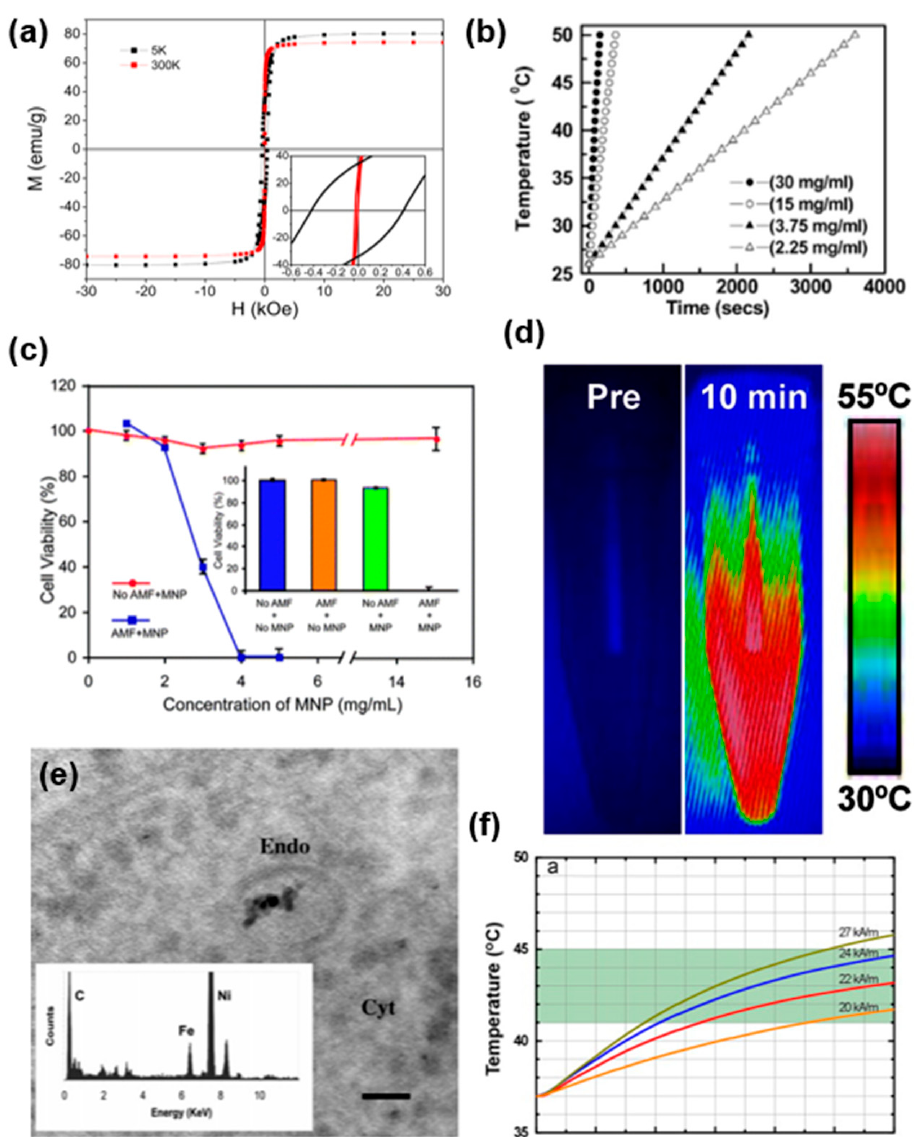
Figure 4. ( a ) Magnetization values of iron oxide MNPs at different field strengths, 5 K (black) and 310 K (red). Inset shows the low field region to estimate the coercive field. Reprinted with permission from [83]. Copyright 2012 American Chemical Society. ( b ) Heat generation of iron oxide base MNPs at 6.5 kA/m magnetic field and 60 kHz. Reprinted with permission from [122]. Copyright 2007 The Royal Society of Chemistry. ( c ) Cell viability of Hela cells using protein-coated iron oxide MNPs. Reprinted with permission from [124]. Copyright 2008 The Royal Society of Chemistry. ( d ) Thermal heating of FA-PEG-SPION MNPs. Reprinted with permission from [126]. Copyright 2013 Ivyspring International. ( e ) TEM image, showing agglomeration of MNPs in an endosome in KB cells and inset showing the EDX analysis. Reprinted with permission from [127]. Copyright 2005 American Chemical Society. ( f ) Heating profile of Fe/MgO under different alternating magnetic field strengths. Reprinted with permission from [131]. Copyright 2011 Elsevier.